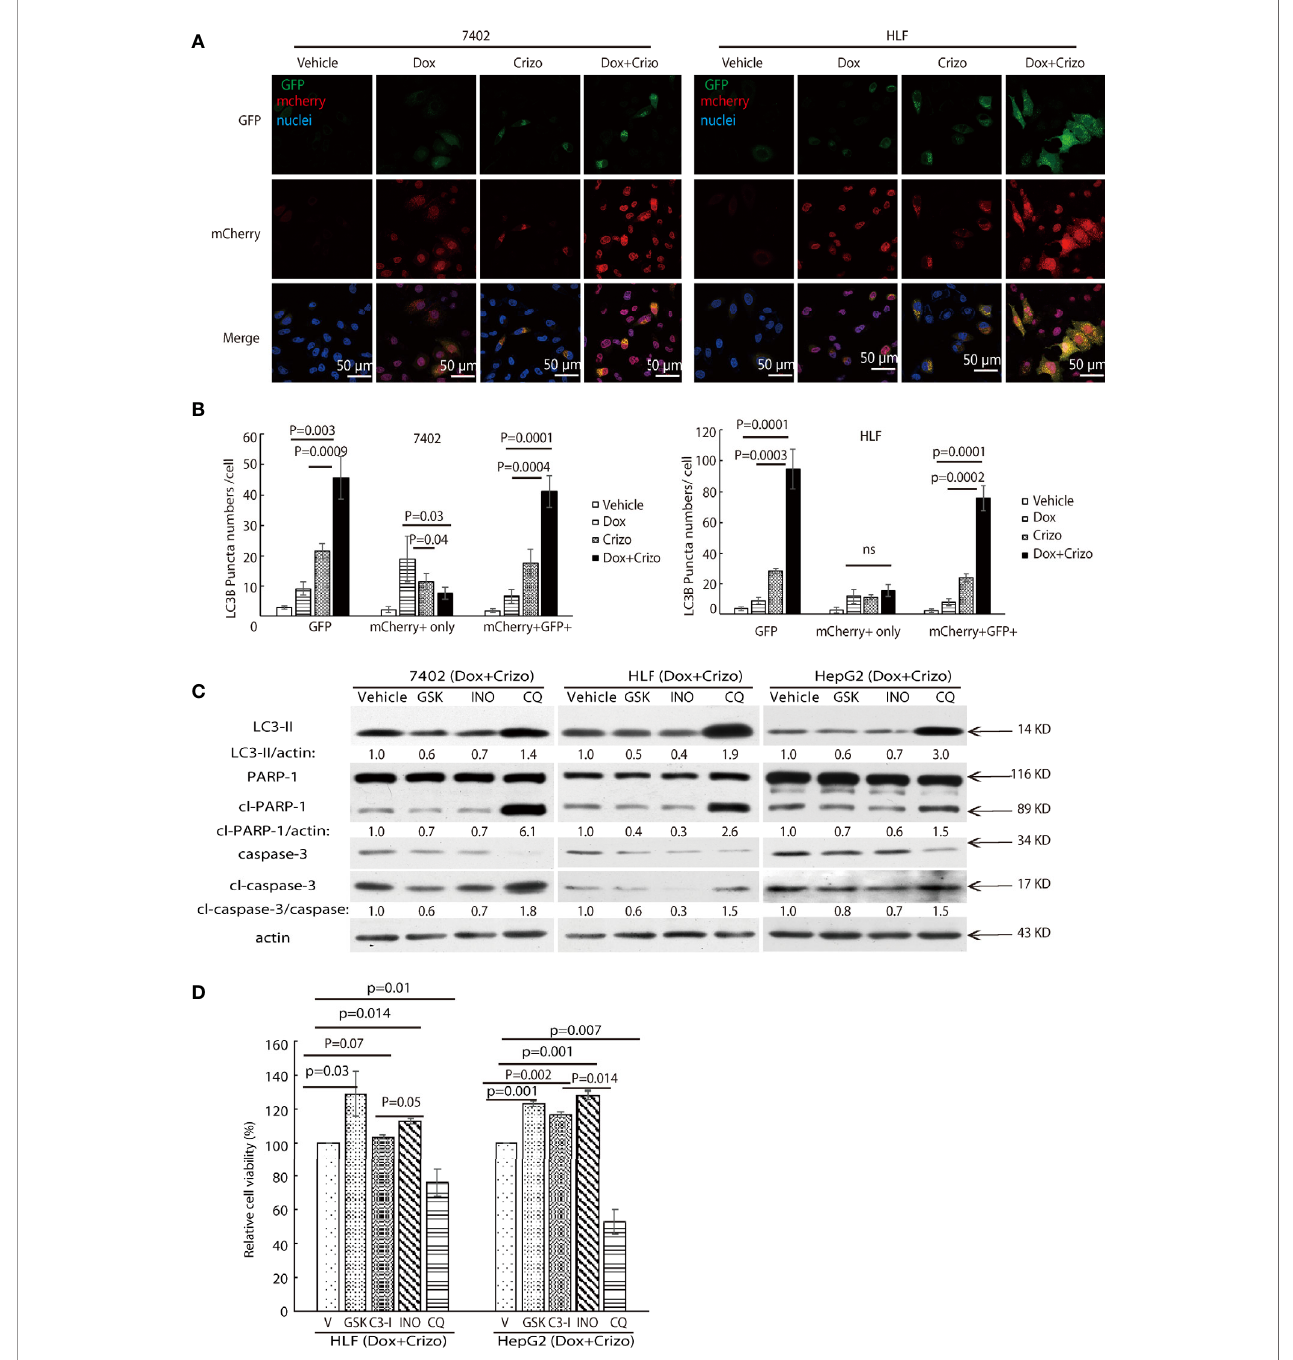
FIGURE 6 | Dox plus Crizo treatment induces PARP-1 dependent cell death. (A) Dox plus Crizo induced autophagosome formation but reduced fusion between autophagosome and lysosome. LC3-GFP-mcherry plasmid transfected cells were treated with vehicle, Dox, Crizo, or Dox plus Crizo for 24 hs and subjected for confocal microscopy observation. (B) Results from three experiments were analyzed. Open and differentially fi lled in bar graph showed that mean and standard deviation of three experiments. (C) In the presence of Dox plus Crizo, HCC cells were treated with vehicle, GSK, INO, or CQ as indicated. GSK and INO treatment consistently reduced LC3-II, caspase-3 activation (cl-caspase-3), and PARP-1 (cl-PARP-1) cleavage whereas CQ activated LC3-II, cleaved caspase-3, and cleaved PARP-1. The experiments were repeated three times with similar results. (D) GSK, INO, and caspase-3 inhibitor (C3-I) treatment decreased Dox plus Crizo ’ s effects on HCC cells whereas CQ treatment increased such an effect based on MTS assays. Cells seeded as triplicates were treated for 24 hours with vehicle (V), GSK, INO, caspas-3 inhibitor, or CQ in the presence of Dox plus Crizo. The experiments were repeated three times with similar results. P values were indicated. Relative protein levels were determined with IMAGE J as speci fi ed. ns, statistically no signi fi cant